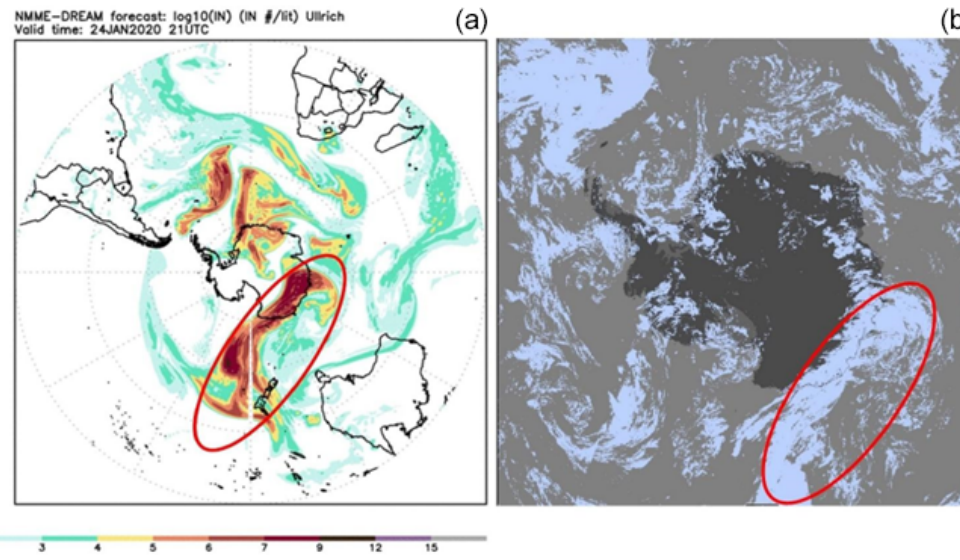
Figure 16. Global NMMB DREAM model experiments over Australia and the South Pole. Model dust load for 22 January 2020 (a) . NASA MODIS ice cloud phase for 24 January 2020 (b)